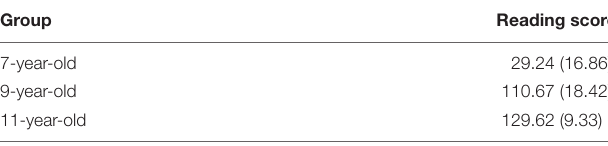
TABLE 1 | Mean scores on the Chinese word recognition